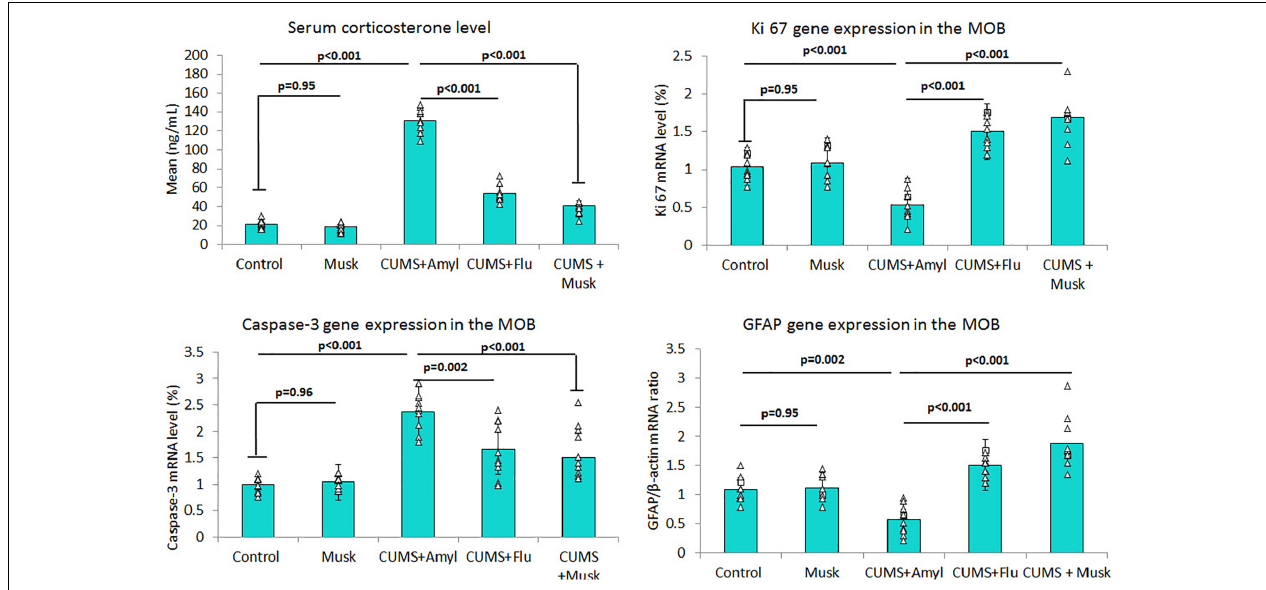
FIGURE 2 | The effect of Flu and musk on serum corticosterone level, Ki67, caspase-3, and GFAP gene expression in MOB. Data are analyzed using a mixed-model two-way ANOVA based on Bonferroni post hoc was used to analyze the data. Results are expressed as mean ± SD ( n = 10). p < 0.05 was considered significant. MOB, main olfactory bulb; CUMS, chronic unpredictable mild stress; Flu,